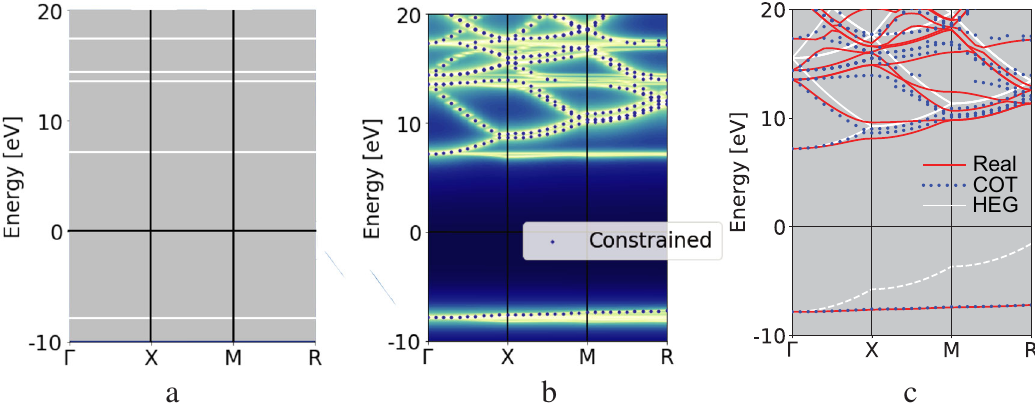
Fig. 4 Band structure of cubic helium. The energies are aligned to the Fermi energy. a White lines are the bands resulting from the direct approximation, where the energies results at all k -points equal those at k 0 . b Connector result, plain (intensity plot) and constrained (blue dots), following the prescription in the text. c Comparison of fi rst principles results (red line) with constrained connector (blue dots). In white, HEG folded into the Brillouin zone of helium and attached to the second band at Γ . For comparison of the lowest band, which corresponds to a localized state, the lowest HEG band is